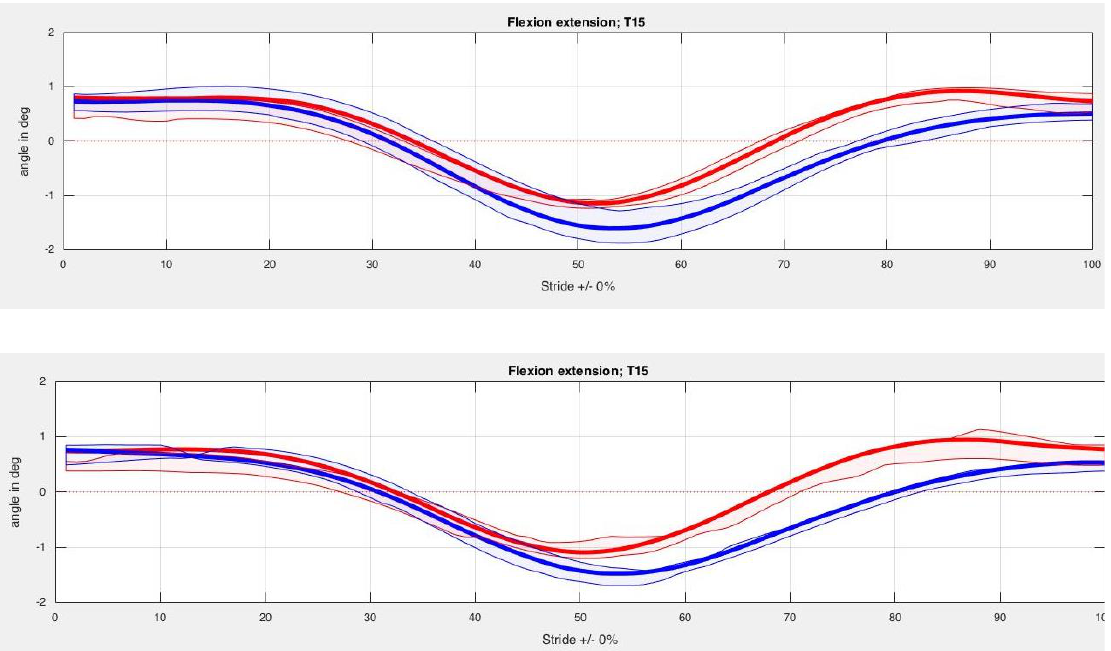
Figure A3. Flexion-extension angular patterns of L3 of horse no. 4 (mean stride) at trot without kinesiotape (the upper graph) and with kinesiotape (the lower graph). The thickened line indicates the mean, shaded area the standard deviation. Left hindlimb red and right hindlimb blue.